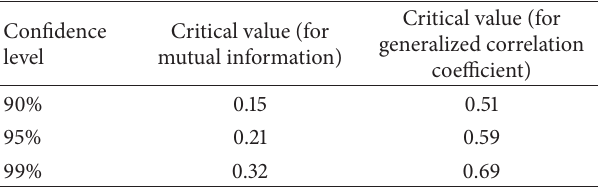
Table 5: Critical values for testing independence.